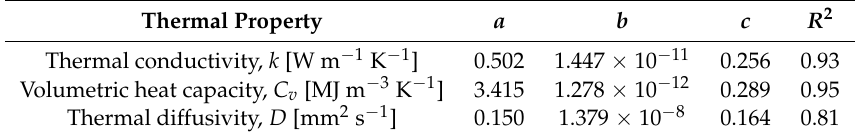
Table 2. Regression coefficients and R-squared of fit function modelling each thermal property with